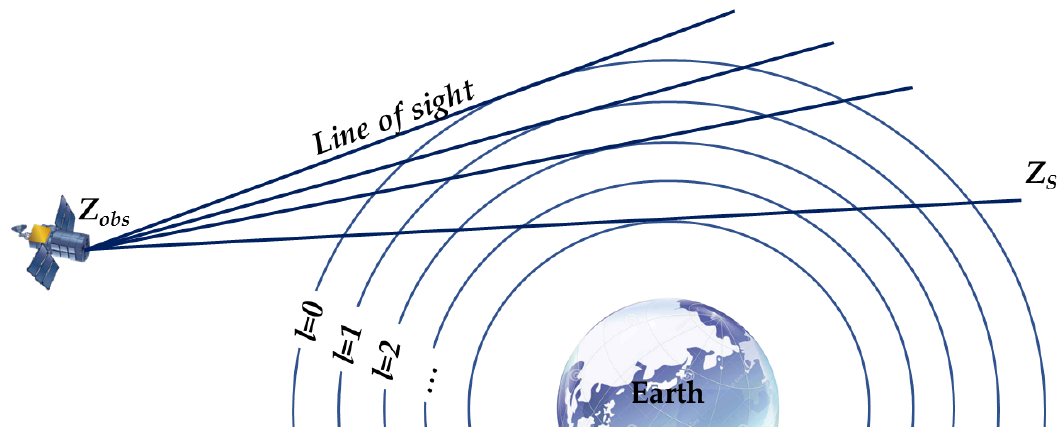
Figure 7. The construction of the path model in limb-viewing geometry.